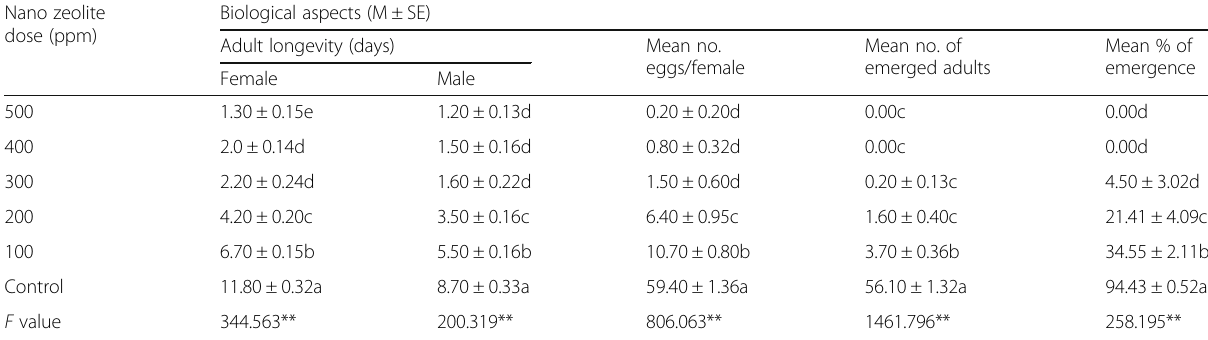
Table 5 Efficacy of nano zeolite on some biological aspects of C. maculatus adults at different dose rates Nano zeolite dose (ppm)